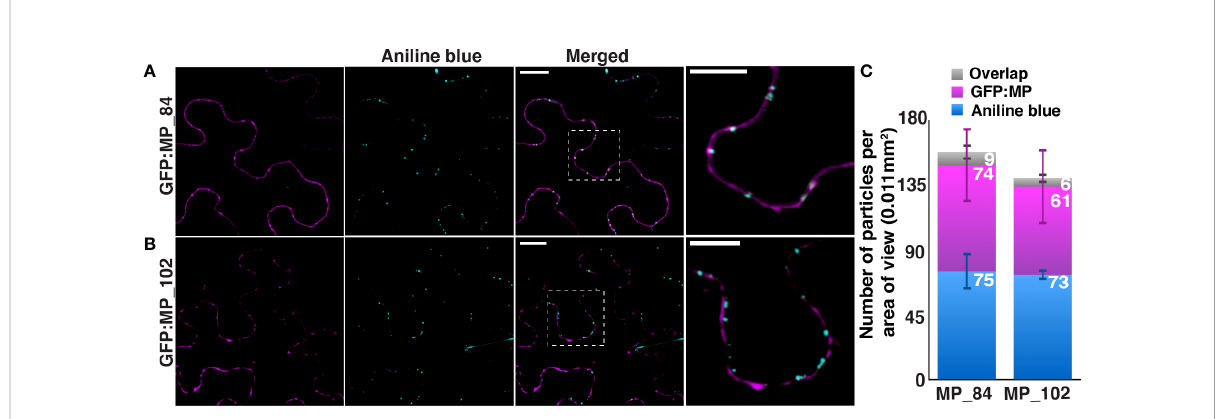
FIGURE 6 Truncated OuMV MP mutants retaining sorting motifs fail to localize to callose deposits. N. benthamiana epidermal cells expressing (A) GFP : MP_84, (B) GFP : MP_102 (magenta) with RdRP and CP. Aniline blue was used to mark callose deposits (cyan). Images represent single optical planes. Scale bar, 15 m m, 10 m m (magni fi ed region). (C) The quanti fi cation of callose deposits (blue), spots labeled by OuMV GFP : MP truncated mutants and co-localized spots (gray) per area of view. The spots were counted using the ComDet plugin in ImageJ. Four areas of view were examined (n=4) and the total number of counted spots for each sample is more than 600. Stacked bar graph represents mean ± standard